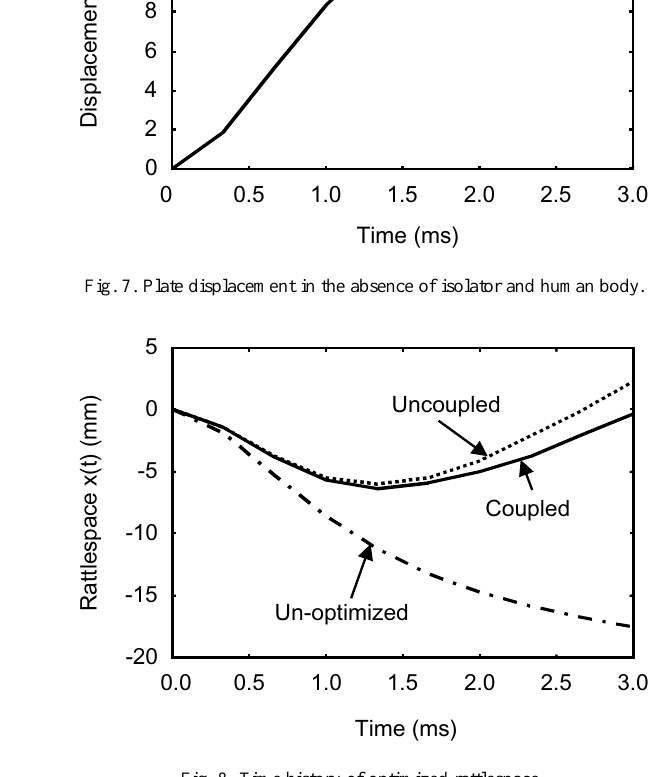
Fig. 8. Time history of optimized